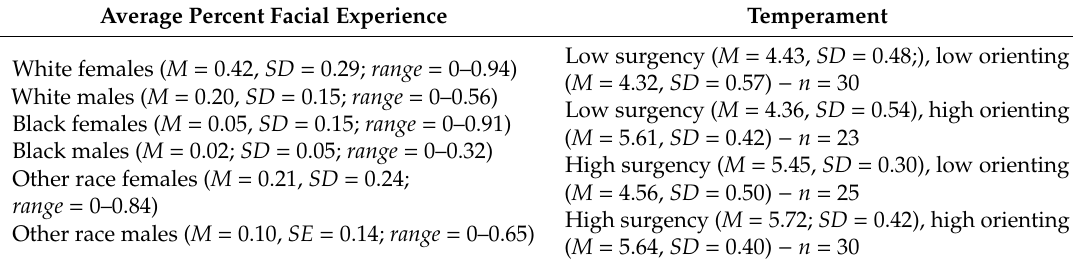
Table 1. Means, standard deviations and ranges for infants’ percent of experience with faces based on gender and race and for the temperament measures. Average Percent Facial Experience Temperament White females ( M = 0.42, SD = 0.29; range =